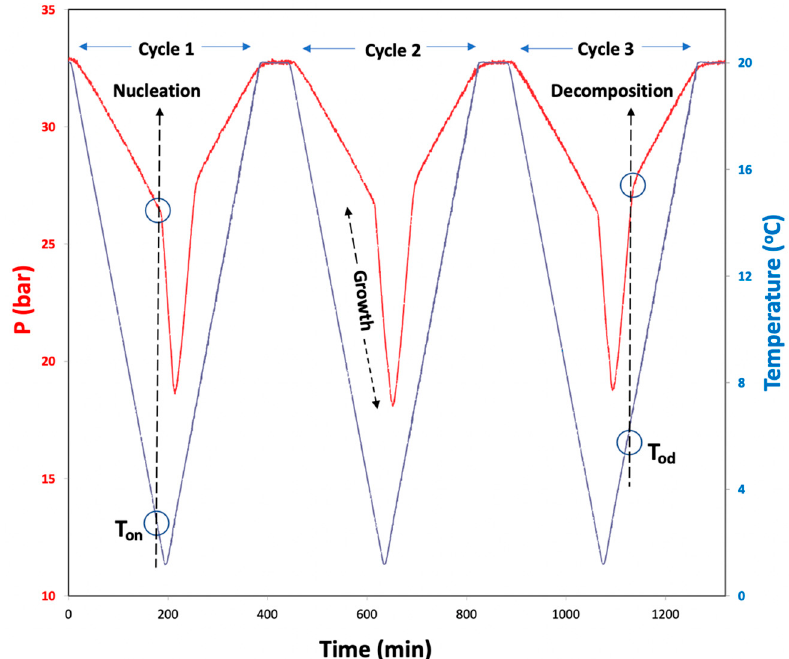
Figure 9. A scheme of constant ramping method cycles and typical P–T and T–t curves obtained for the (CO 2 + H 2 O) system. The hydrate nucleation onset temperature (T on ), growth and dissociation onset temperature (T od ) are indicated on the curves.